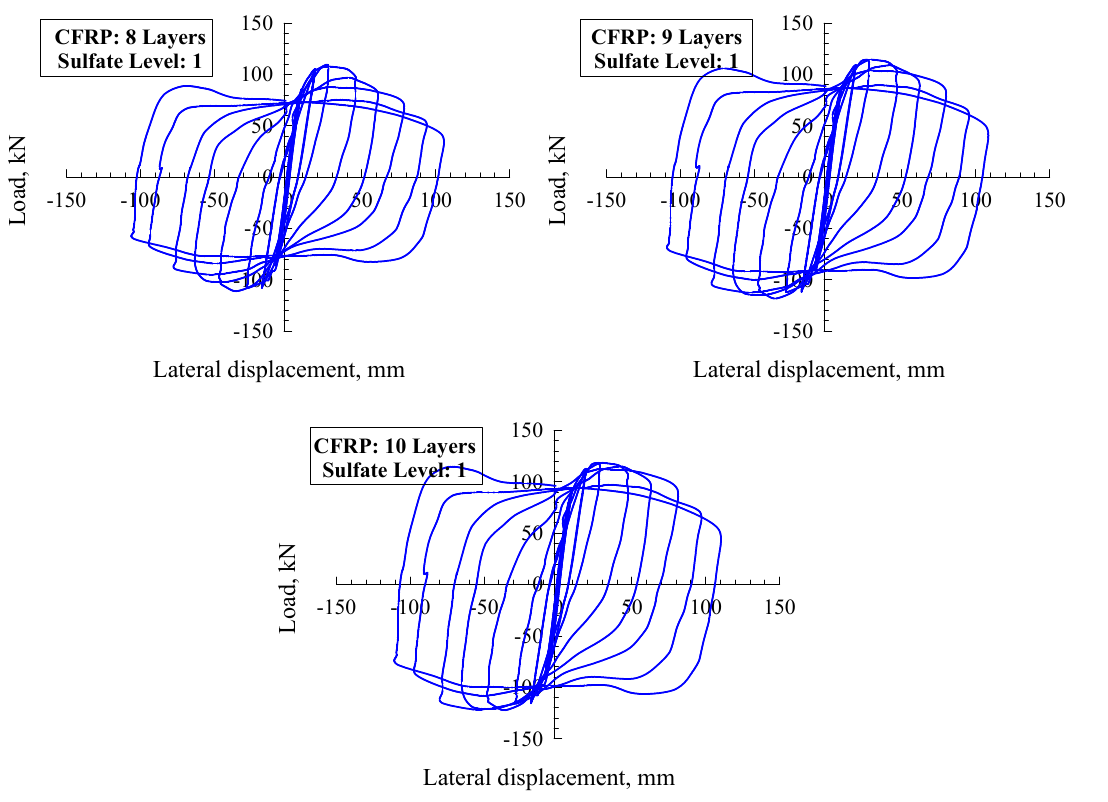
Figure 8. CFT column horizontal load–net drift hysteresis loops for sulfate level 1.